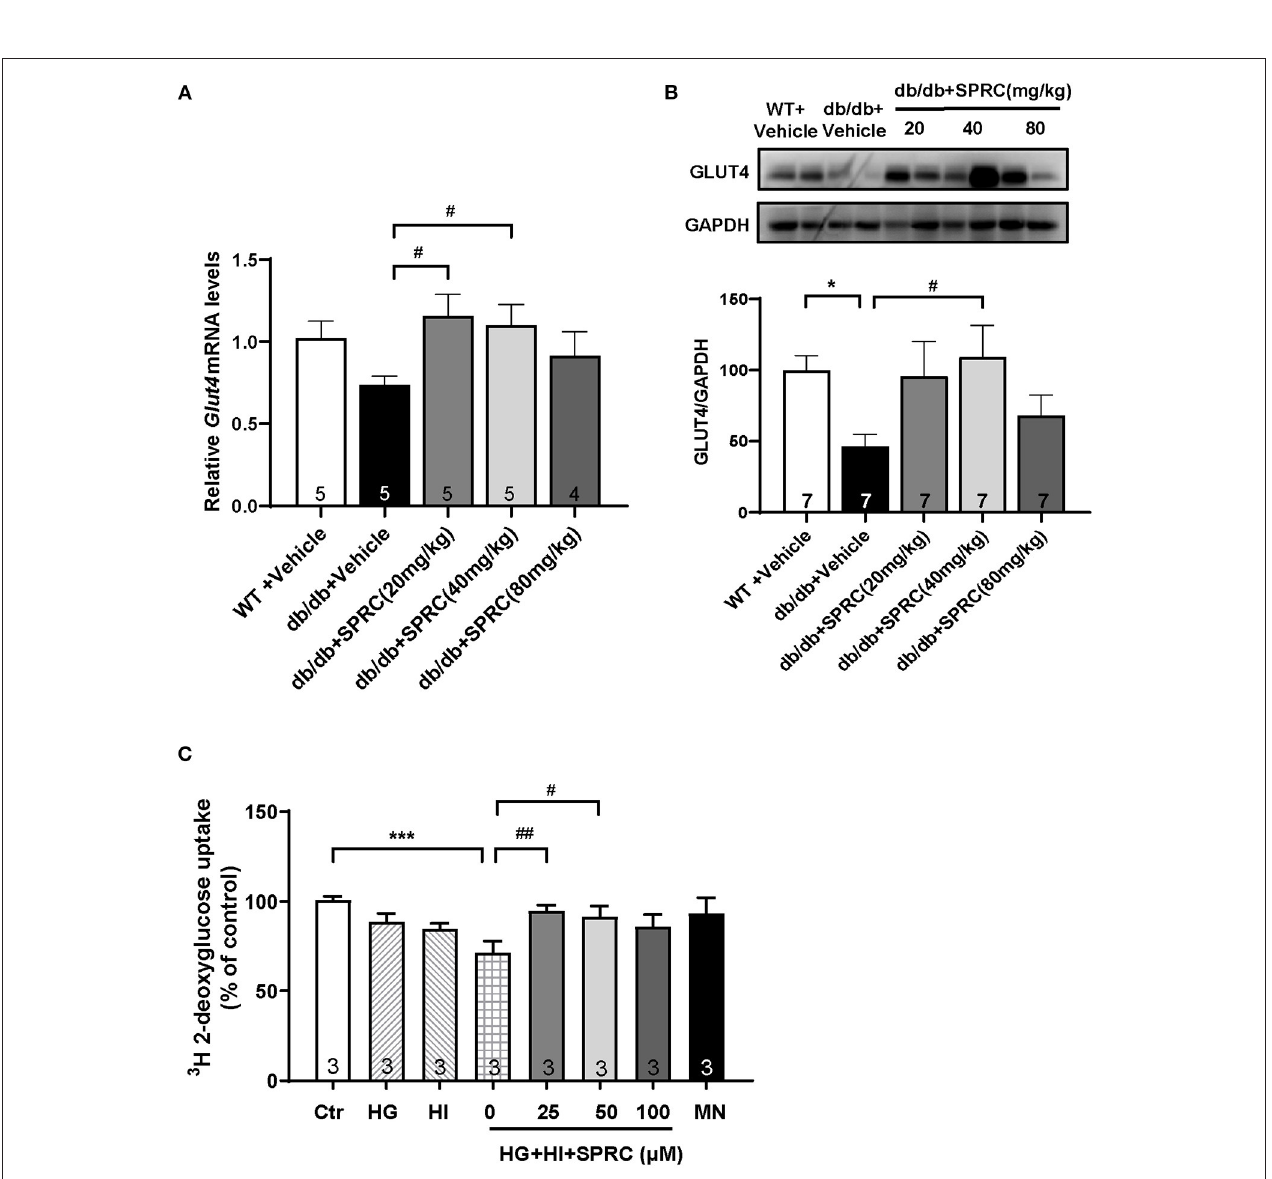
FIGURE 8 | SPRC treatment increased GLUT4 expression and enhanced 3 H glucose uptake. Vehicle or SPRC (20, 40, or 80 mg/kg/day) was orally administered to WT mice or db/db mice for 12 weeks. (A) The mRNA levels of Glut4 were determined by real-time qPCR, and the mRNA levels of Gapdh was used as reference for normalization ( n = 4–5). # P < 0.05 vs. db/db + Vehicle mice. (B) The expression level of Glut4 in the myocardium were determined by western blotting ( n = 7). * P < 0.05, ** P < 0.01, and *** P < 0.001 vs. WT + Vehicle group, # P < 0.05, ## P < 0.01, and ### P < 0.001 vs. db/db + Vehicle mice. (C) Primary mice cardiomyocytes were incubated with 33.3mM glucose (HG), 100nM insulin (HI), or 33.3mM glucose + 100nM insulin (HG + HI) for 48h. The cardiomyocytes were then incubation with SPRC (50 µ M) for 24h. 3 H glucose uptake was measured in a liquid scintillation counter and the concentration of protein were detected by BCA method for standardization ( n = 3). * P < 0.05 and *** P < 0.001 vs. control group, # P < 0.05, ## P < 0.01 vs. HG + HI group. Values are presented as means ±